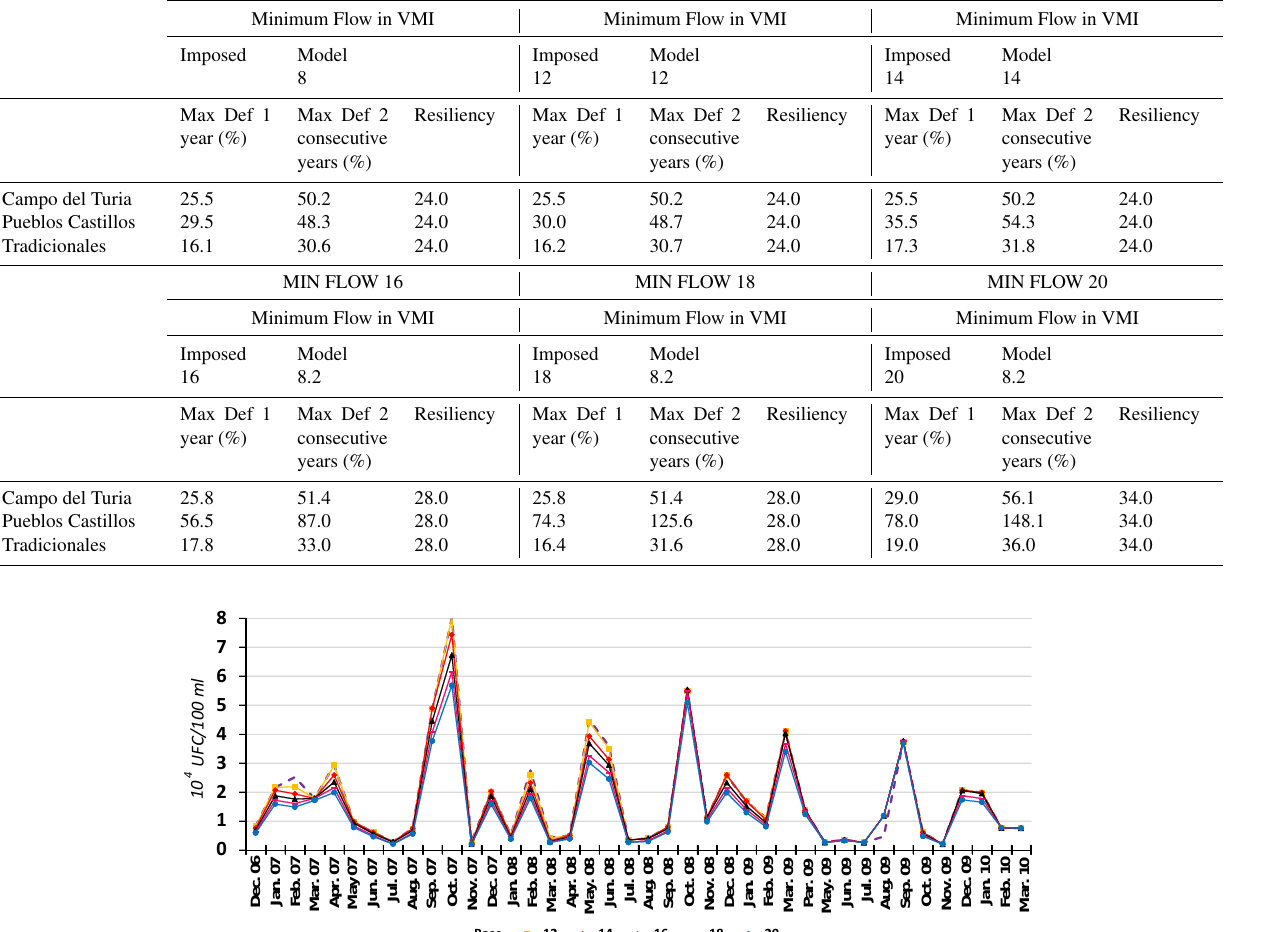
Figure 5. Concentrations of simulated Total Coliforms (TC) near the intake of Valencia City water for different environmental flow (imposed minimum flow)